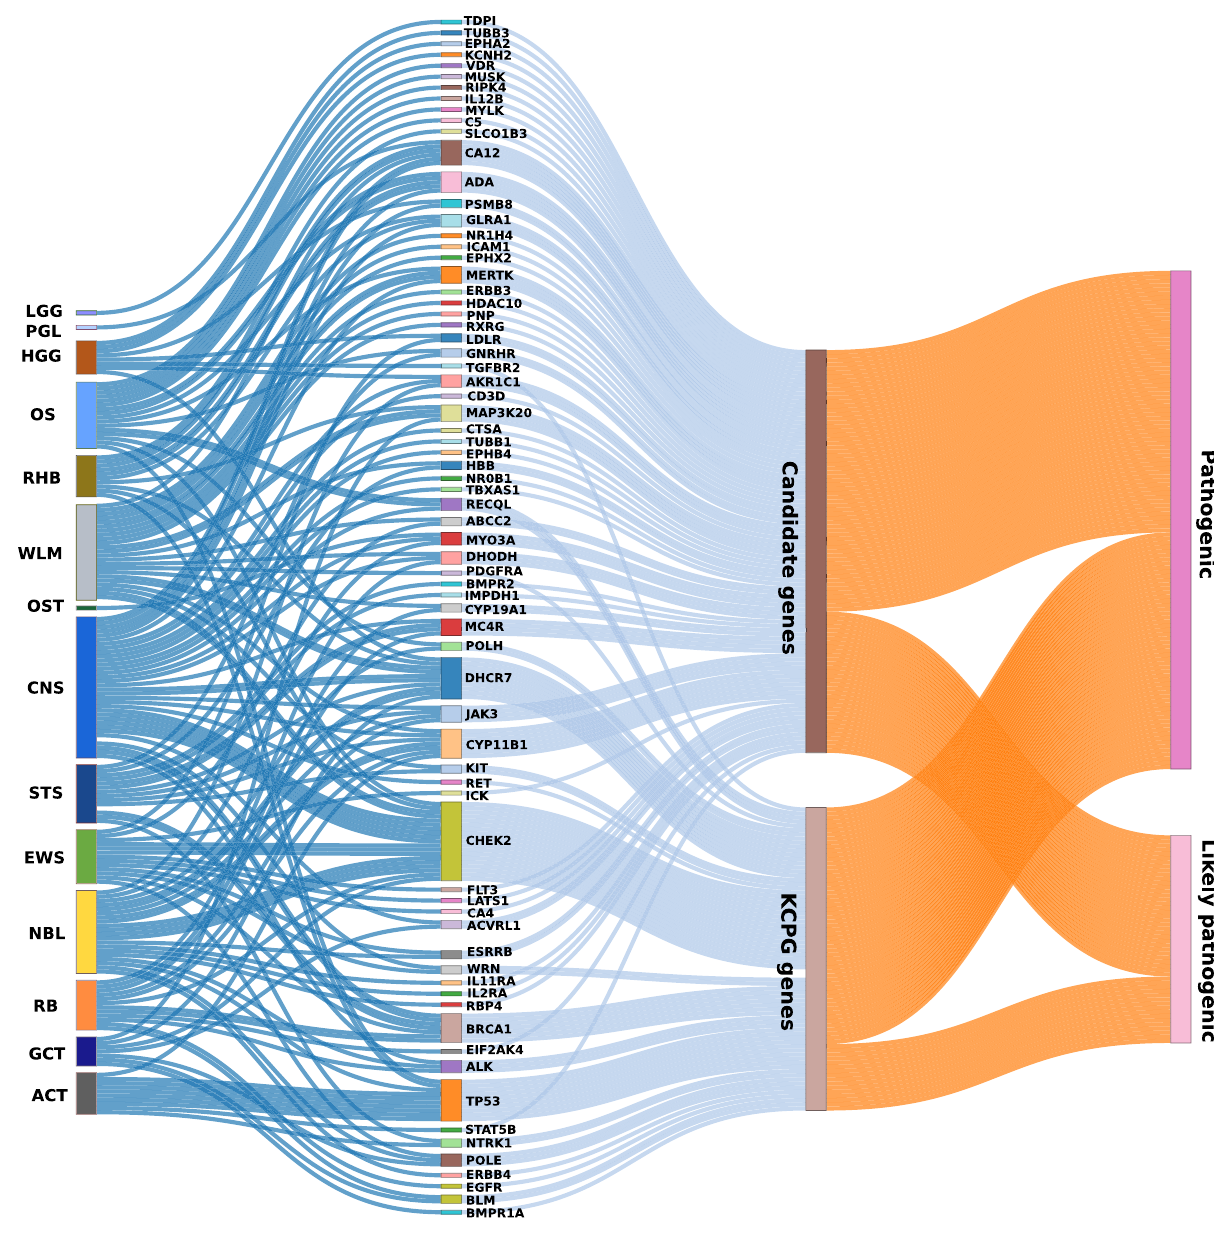
Fig. 5 Drug – target network analysis in children, adolescents, and young adults (C-AYA) with solid tumors. Known cancer-predisposing genes (KCPG) and candidate genes with germline pathogenic/likely pathogenic (P/LP) variants in C-AYA patients with solid tumors that have existing FDA-approved antineoplastic and immunomodulating-related compounds, in regard to their affected tumor types. ACT adrenocortical carcinoma, CNS central nervous system, EWS Ewing sarcoma, GCT germ cell tumor, HGG high-grade glioma, LGG low-grade glioma, NBL neuroblastoma, NM non-malignant tumor, OS osteosarcoma, OST other solid tumors, PGL paraganglioma, RB retinoblastoma, RHB rhabdomyosarcoma, STS soft tissue sarcoma, WLM Wilms